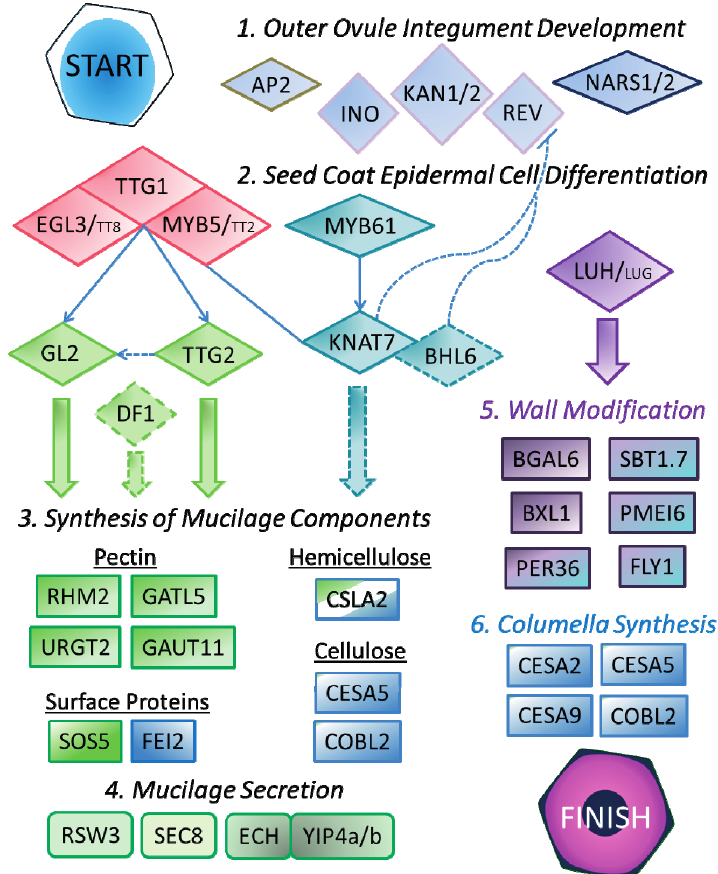
Figure 3. A simplified model of SCE development showing transcription factors (diamonds) and enzymes or other proteins (rectangles) involved in cell wall production. Slashes denote functionally redundant homologs, and colors highlight proteins with similar functions. Overlapping shapes form a protein complex. In addition, KNAT7 can directly interact with MYB5. Thin arrows indicate direct transcriptional activation, while dashes show putative interactions that have not been validated in SCE